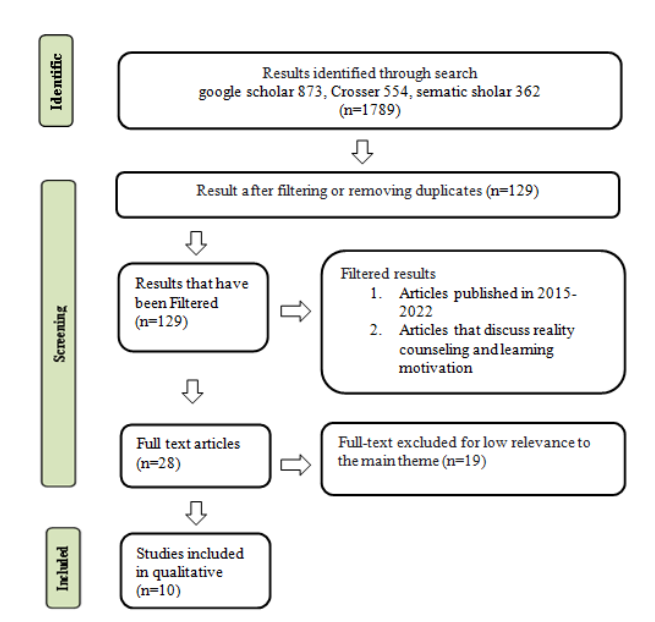
Figure < Flow Chart of Literature Search and Selection